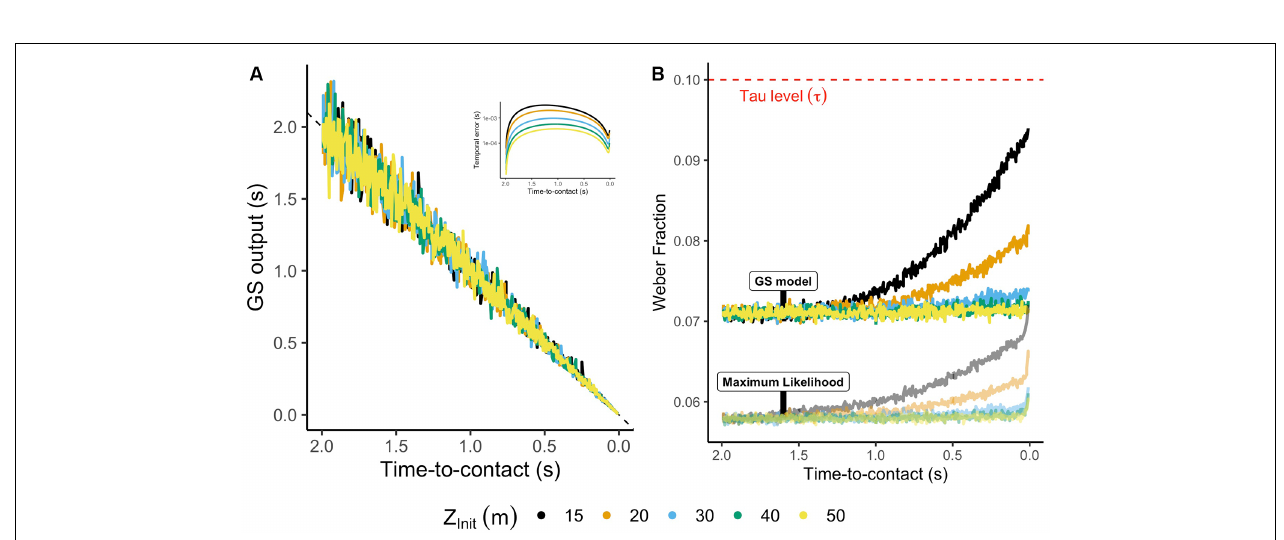
FIGURE 7 | (A) Noisified estimates of TTC using the GS model for different trajectories. The inset represents the temporal error for the noiseless output of the GS model. (B) Weber fraction (WF) computed as the ratio between standard deviation and mean of the GS model each temporal frame. The red dashed line indicates the mean WF of Tau (see main text). The translucid output indicates the WF of a combination of the GS model and Tau using an MLE